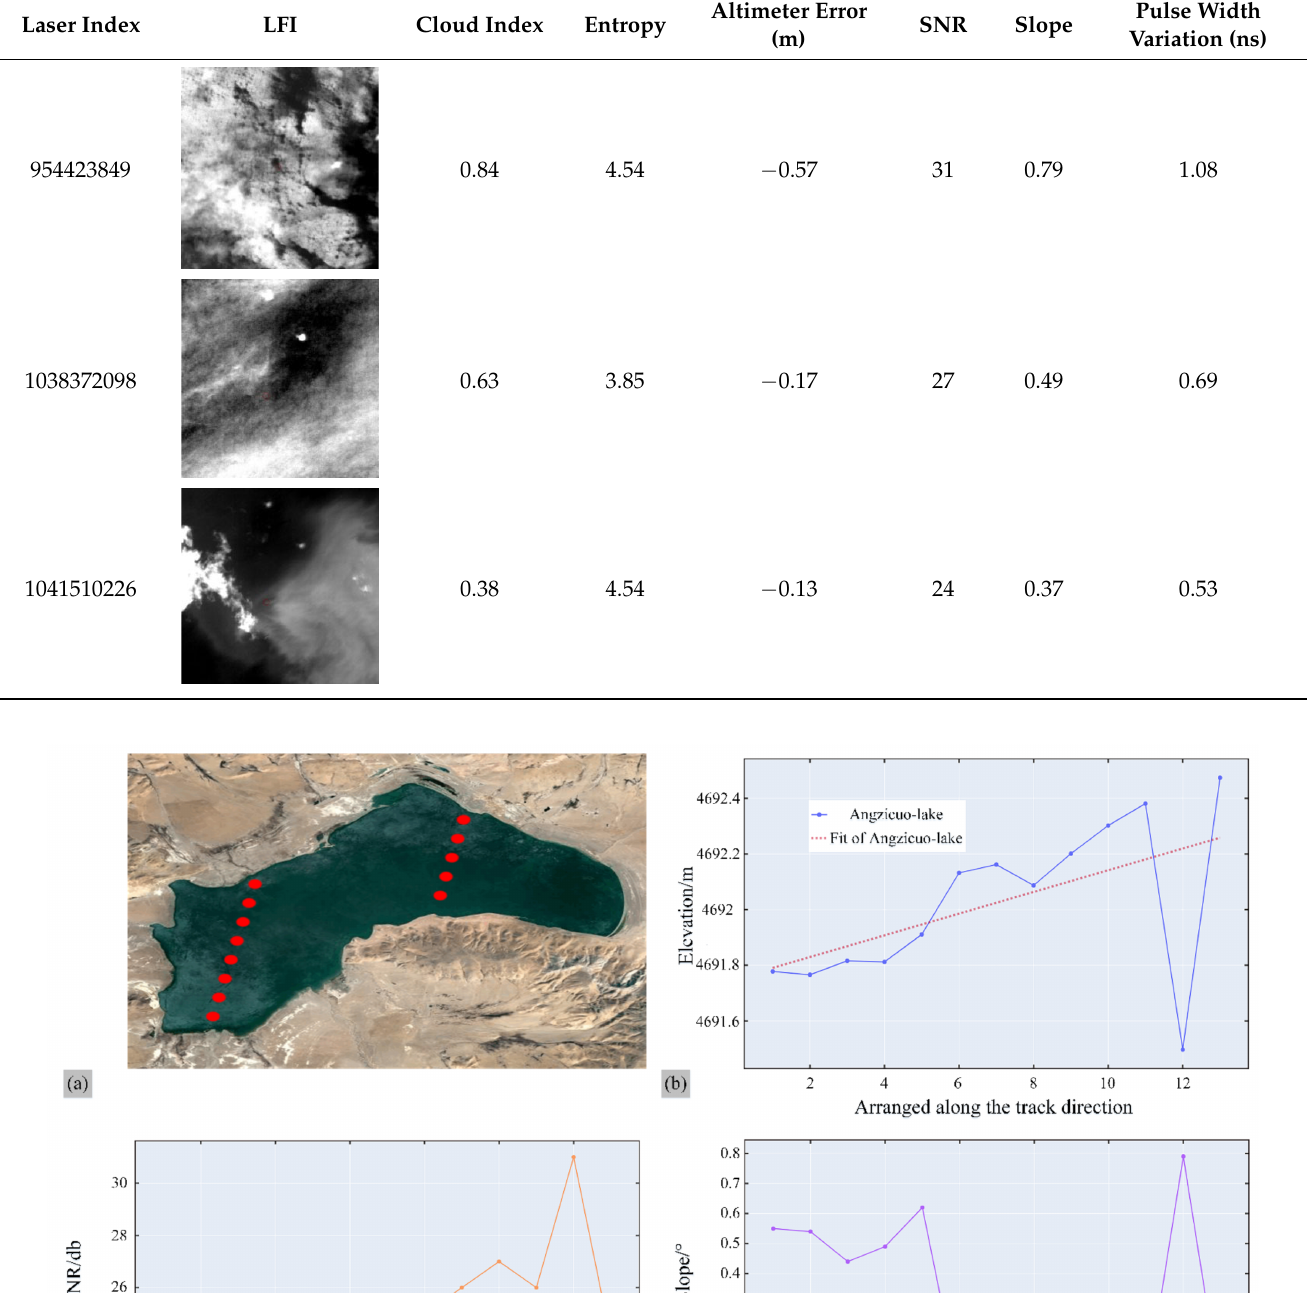
Table 8. Influence of multiple scattering of thin clouds on the laser.